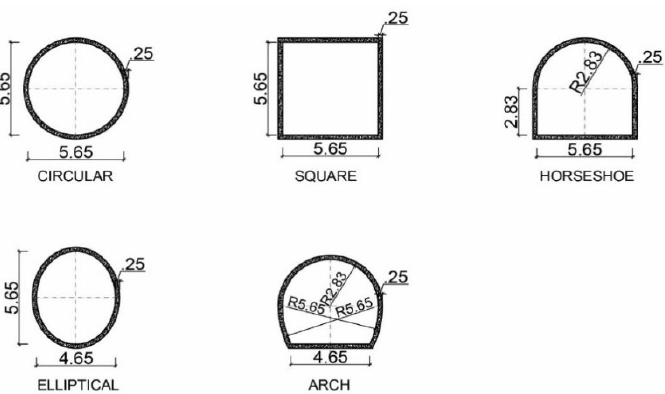
Figure 9. Shapes of lining considered for numerical study (all dimensions are in meters). Table 2. Properties of concrete